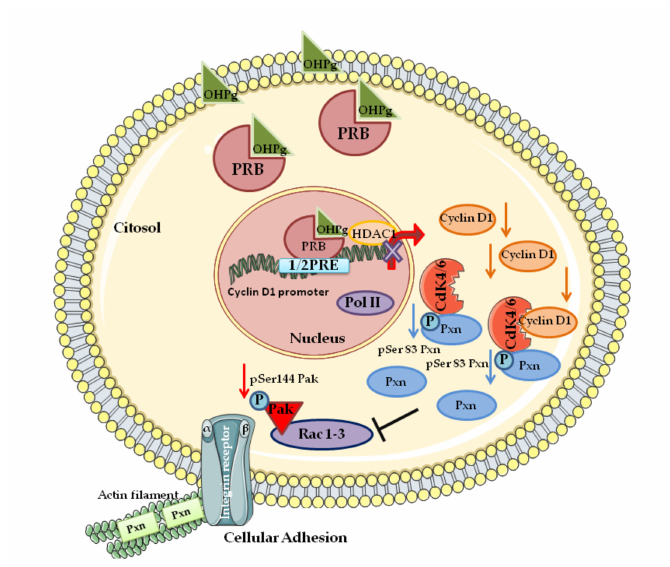
Figure 2. A schematic summary illustrating Cyclin D1 as a key target of ligand-activated progesterone receptor (PR)-B in breast cancer cells invasion. [88]. hydroxyprogesterone (OHPg) / PR-B reduce Cyclin D1 expression by transcriptional regulation due to the recruitment of PR-B on Cyclin D1 promoter. Cyclin D1 / cyclin-dependent kinase 4 (CDK4) / paxillin (Pxn) complex, pSer83Pxn, Rac, and Pak are inhibited causing delay of cell invasion and migration. See the text for details. Abbreviations: PRE (progesterone responsive element), histone deacetylases (HDAC1), Pol II (RNA polymerase II). High levels of Cyclin D1 / CDK4 also promote GBM cells dissemination. Cyclin D1 induces